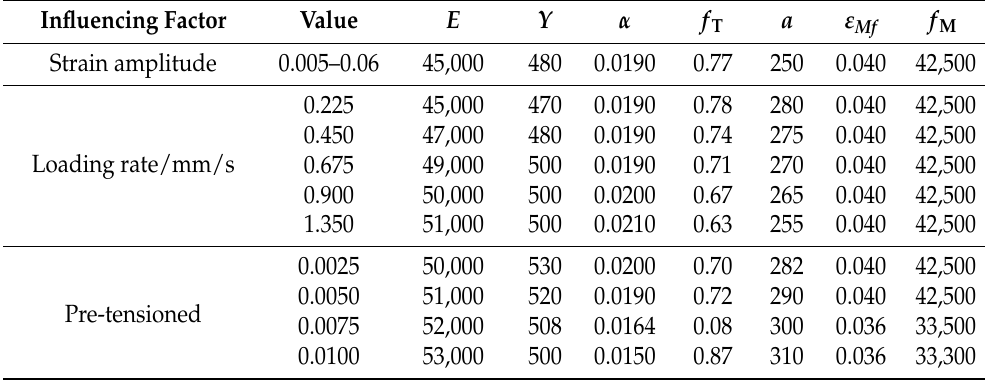
Table 2. The parameters for each mechanical model.